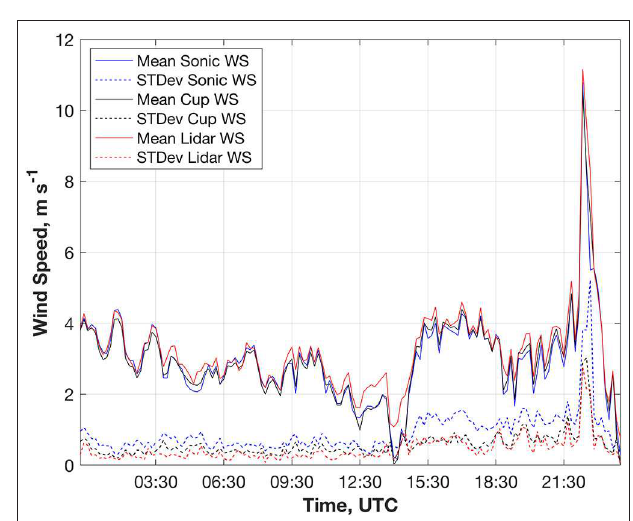
FIGURE 8 | Comparison of the 10min averaged horizontal wind speeds and 10min standard deviations of the horizontal wind speeds of the different measurement platforms at the One Energy calibration complex on 23 July